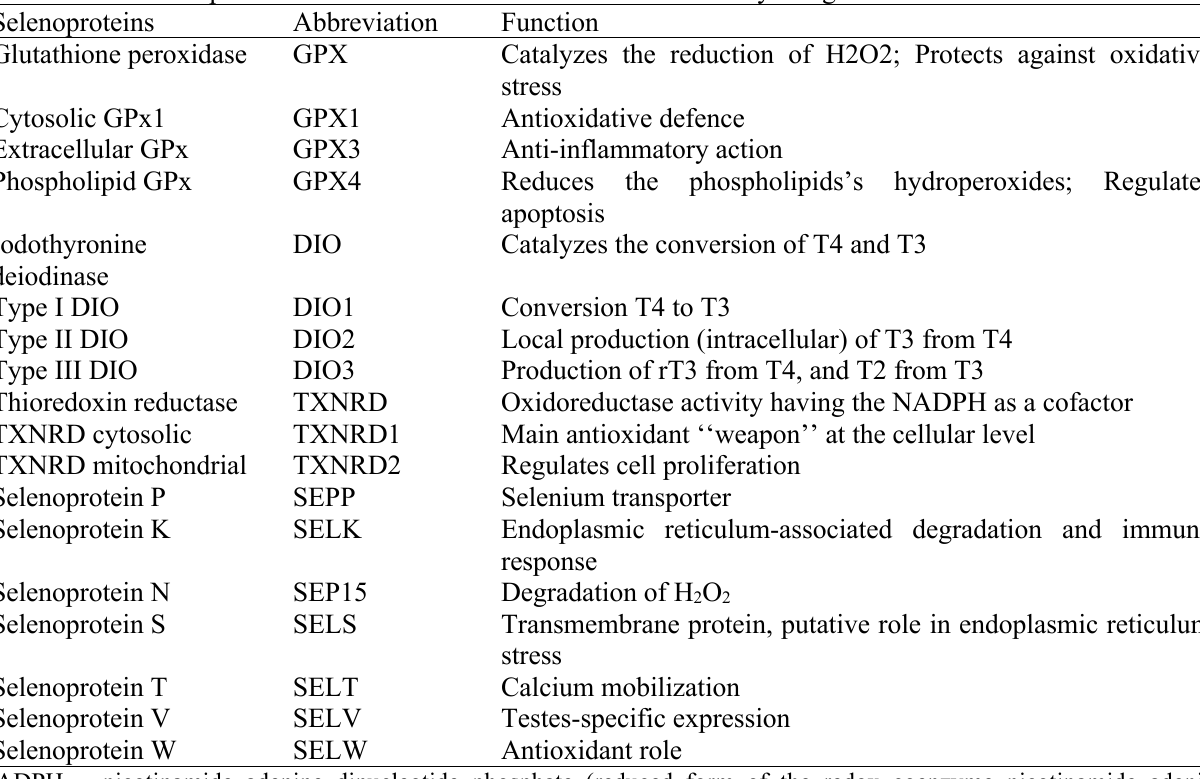
Table 3. Main selenoproteins and their function that are found in the thyroid gland